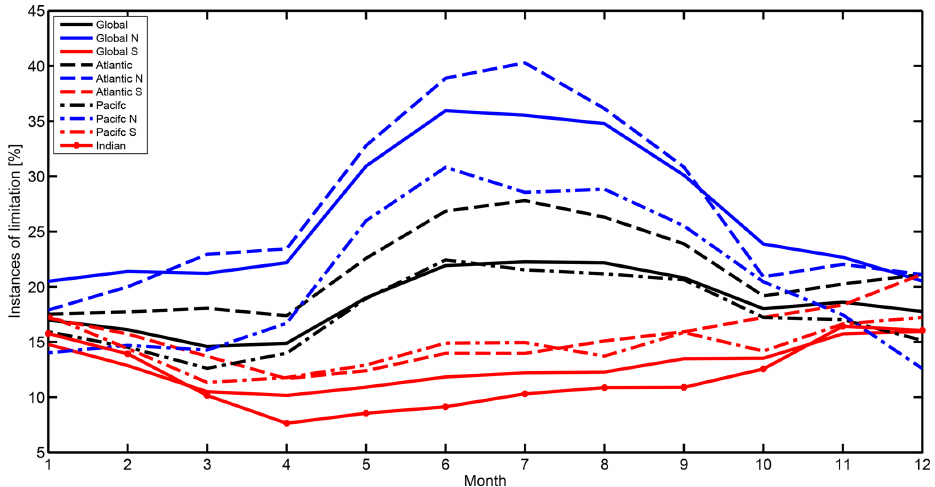
Figure 8. The probability of experiencing gas transfer suppression during the respective month (2014) divided into ocean basins and hemi- spheres. The Southern Ocean was added to the southern part of the respective ocean basin. The percentage is the number of gas transfer suppressed instances with respect to the total datapoints with a 3h resolution.